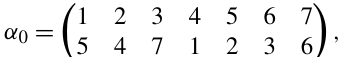
As to the elastic and frictional properties, we take µ = 30 GPa, ν = 0 . 25 and an effective coefficient of friction κ = 0 . 6. The areas and the locations of the faults have been inferred by employing the distances between hypocentres along the strike direction as constraints (Caporali and Os- tini, 2012; Serpelloni et al., 2012). The distances between the centres of the faults are r 12 = r 23 = r 67 = 5 km, r 34 = r 56 = 8 km, and r 45 = 12 km. The projection of the faults on a ver- tical plane is shown in Fig.